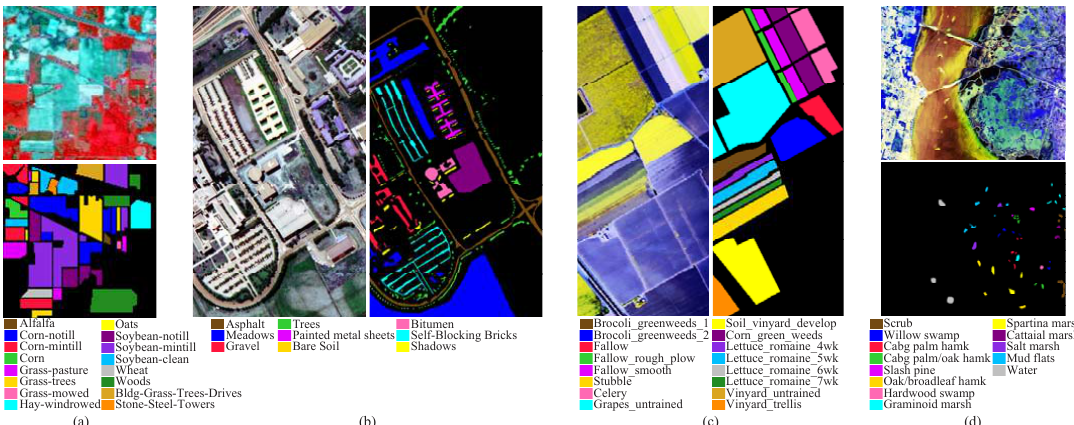
Figure 4. Pseudo-color and ground references for the following datasets. ( a ) Indian Pines; ( b ) University of Pavia; ( c ) Salinas; ( d )